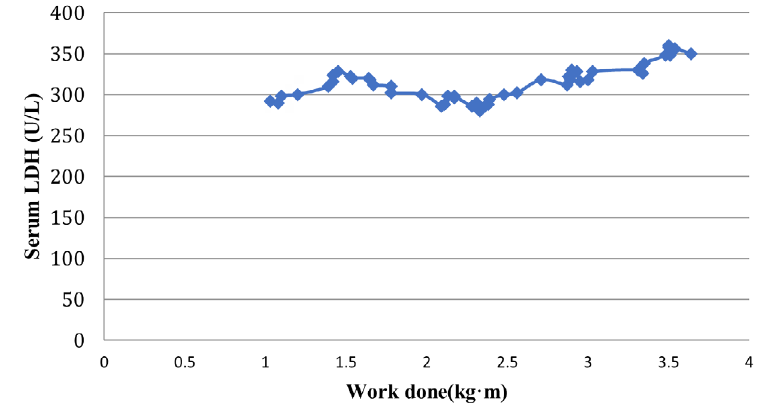
A similar scatter plot representation of the correlation of serum LDH and work done by exercising muscle in prediabetic females is shown in Figure 4.